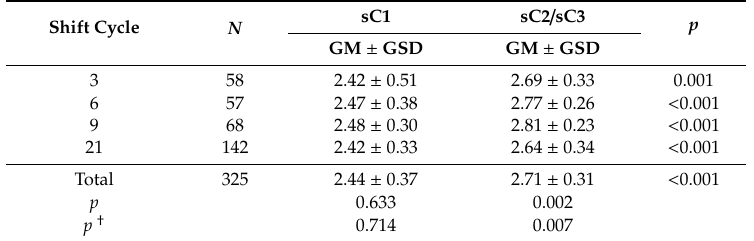
Table 3. The di ff erence of serum cortisol level by working time and shift cycles (unit: µ g / dL). Shift